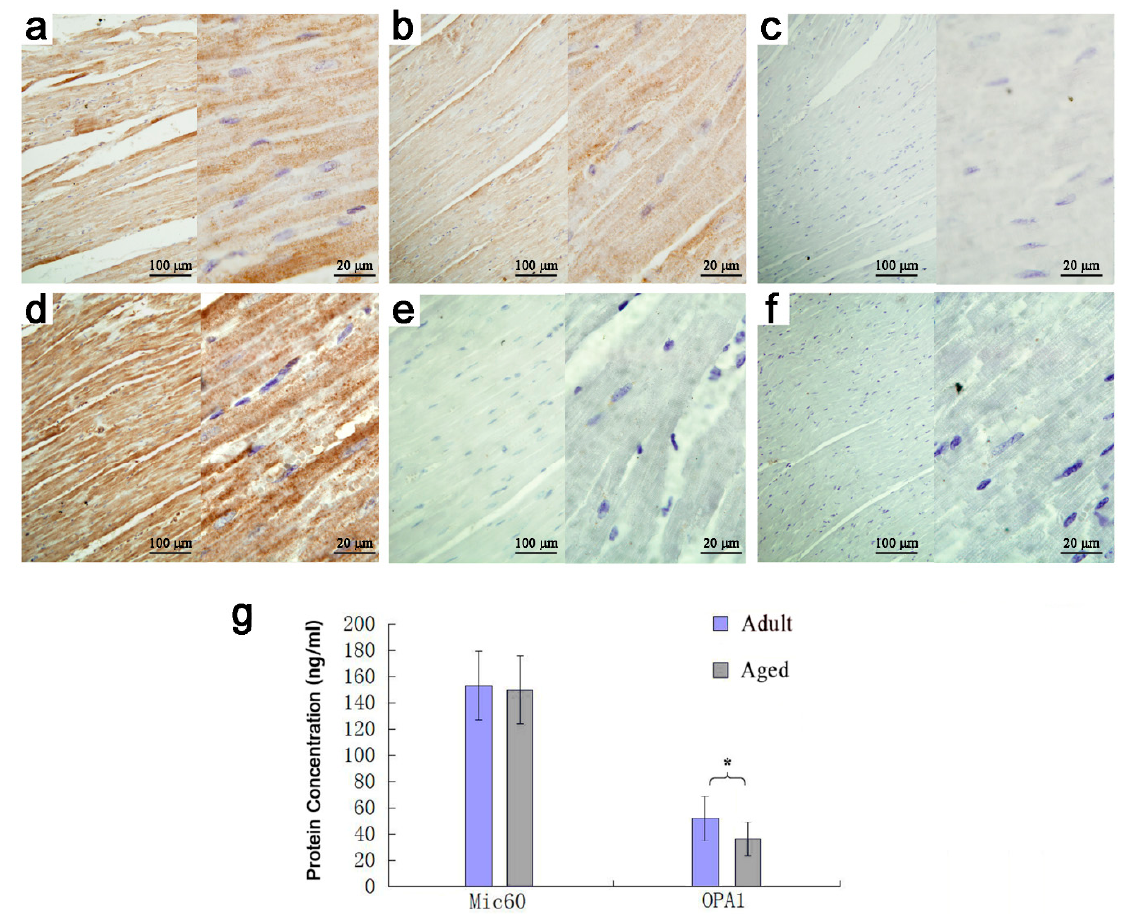
Figure 2. Expression of Mic60 and OPA1 proteins in cardiomyocytes. Note: ( a – c ): Expression of Mic60 protein in adult and aged Tibetan sheep myocardium and blank control. ( d – f) : Expression of OPA1 protein in adult and aged Tibetan sheep myocardium and blank control. ( g ): Protein concentration of Mic60 and OPA1 . Data show means ± SD ( n = 3). * p < 0.05.